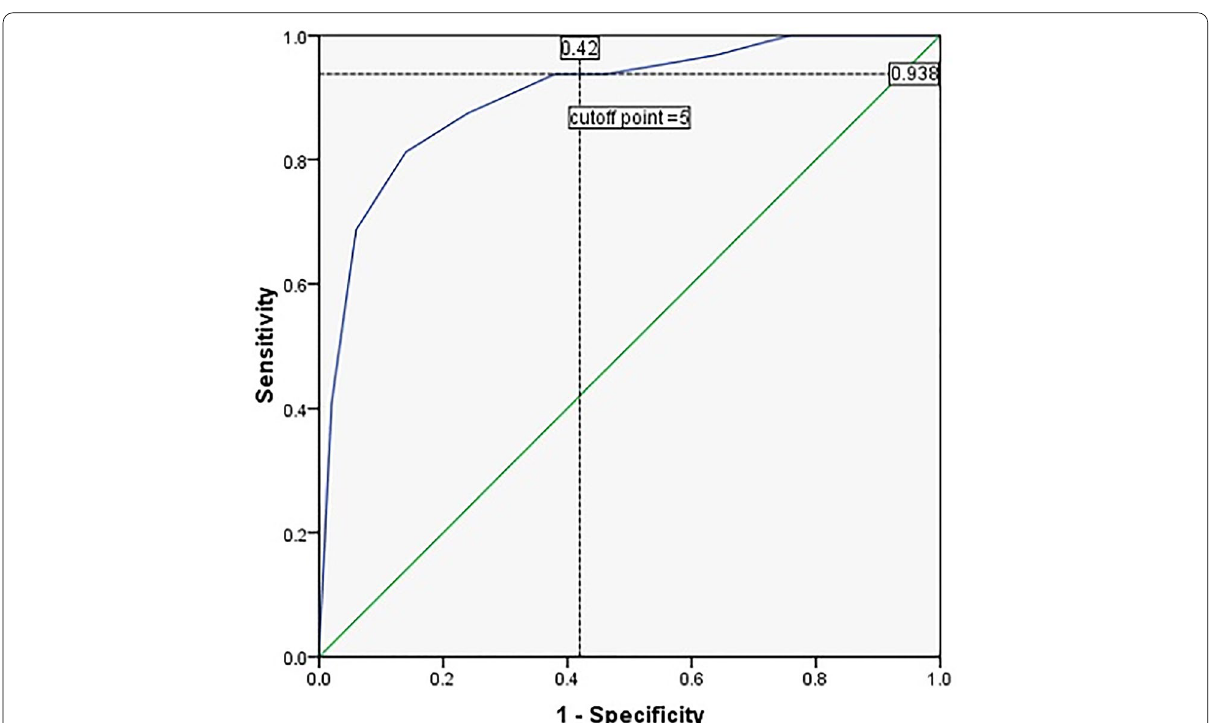
Fig. 4 ROC curve constructed to determine the cutoff value of the score with a sensitivity of 93.8% and a specificity of 58% in detecting COVID-19 positive